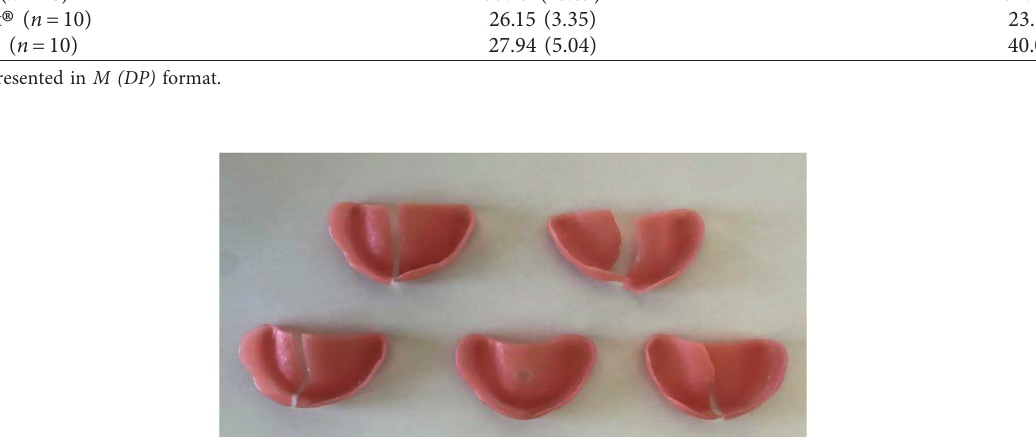
Figure 19: Megacryl ® prosthesis bases subjected to pH 4 after